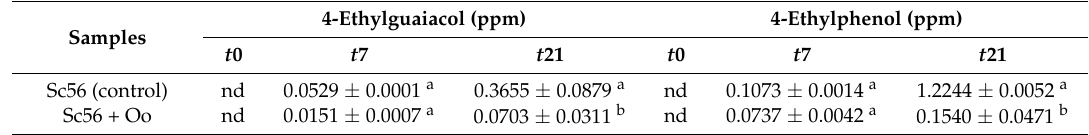
Table 4. Volatile phenol content (ppm) of grape musts spiked with B. bruxellensis Unifg 8 and inoculated with S. cerevisiae KT029756 or co-inoculated with S. cerevisiae KT029756/ O. oeni Unifg 21 during AF: t 0, day of inoculation; t 7, 7 days from the inoculation; t 21, 21 days from the inoculation (nd, volatile phenol not detected). Results of the ANOVA analysis are shown as letters on the data corresponding to the concentration of volatile phenols: different letters on the same column indicate significant differences of